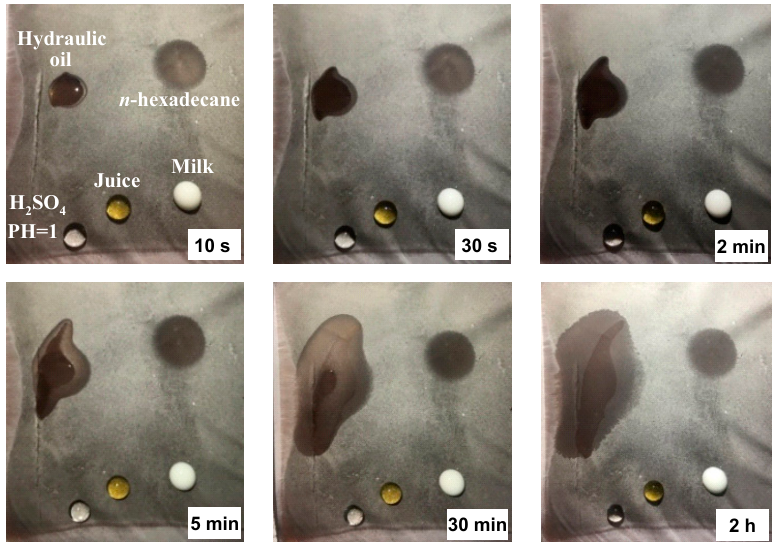
Figure 6. The evolution of various liquid droplets (~0.15 mL) on the electrospun membrane collected on a heating substrate at different time: ( a ) 10 s, ( b ) 30 s, ( c ) 2 min, ( d ) 5 min, ( e ) 30 min, and ( f ) 2 h. The surface tensions are 29.7, 27.2, 40.5, 31.9, and 73.5 dyn/cm for hydraulic oil, n -hexadecane, milk, juice, and H 2 SO 4 , respectively. The viscosities are 3.36 cP for n -hexadecane and 190 cP for hydraulic oil.